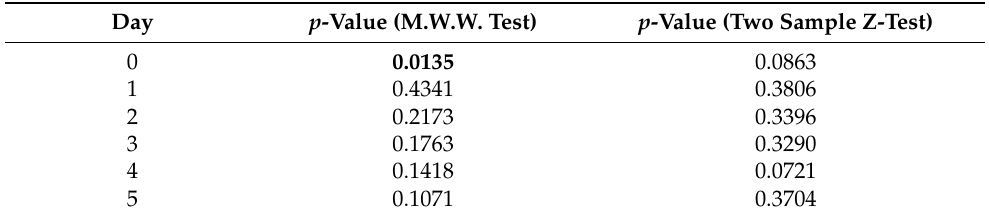
Table A6. Mann-Whitney-Wilcoxon test and the Two-Sample Z-test—Comparing Royal Dutch Shell and Exxon Mobil regarding the induced seismicity in the US ( df =